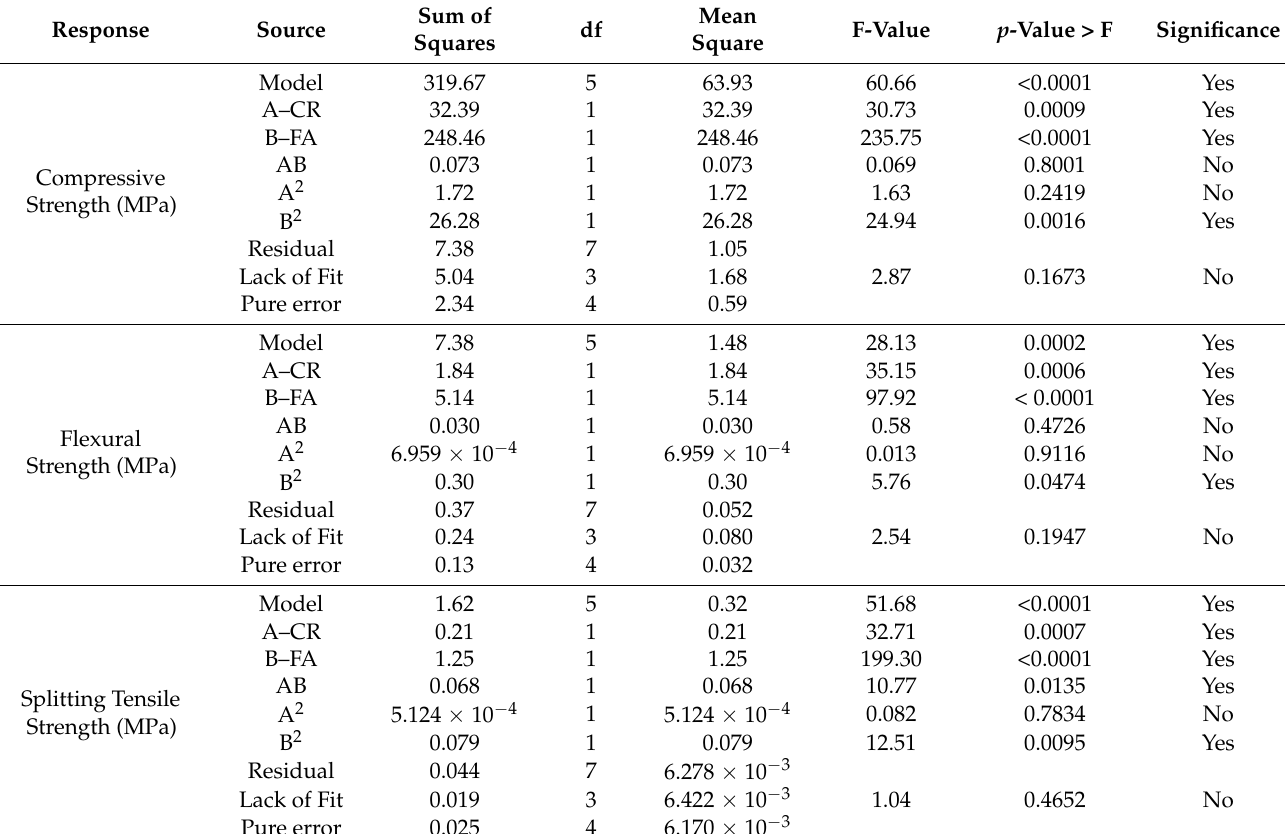
Table 4. Result of the